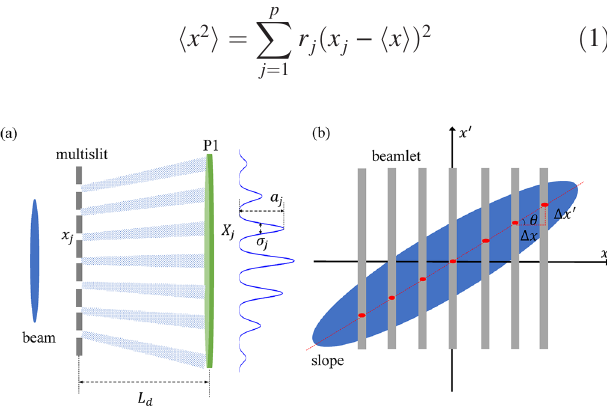
FIG. 2. (a) Schematic of emittance measurement with multislit method; (b) Definition of the ellipse